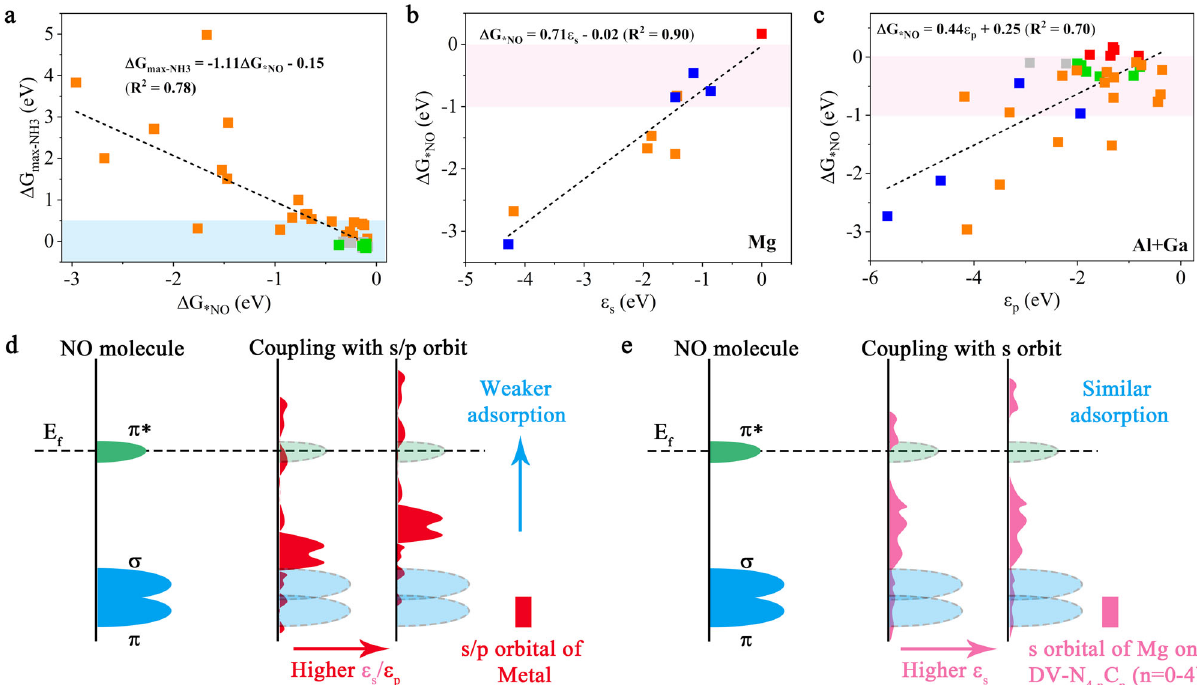
Fig. 6 Descriptor and physical mechanism of catalytic activity. a Δ G max-NH3 as a function of Δ G *NO . b Δ G *NO as a function of s-band centers of Mg on SV/PP-related SAC candidates. c Δ G *NO as a function of p-band centers of Al/Ga on SV/DV/PP-related SAC candidates. d , e Schematic illustrations of the interactions between NO molecular orbitals and s/p-band of main-group metals. The color code of ( a – c ) is consistent with Fig.